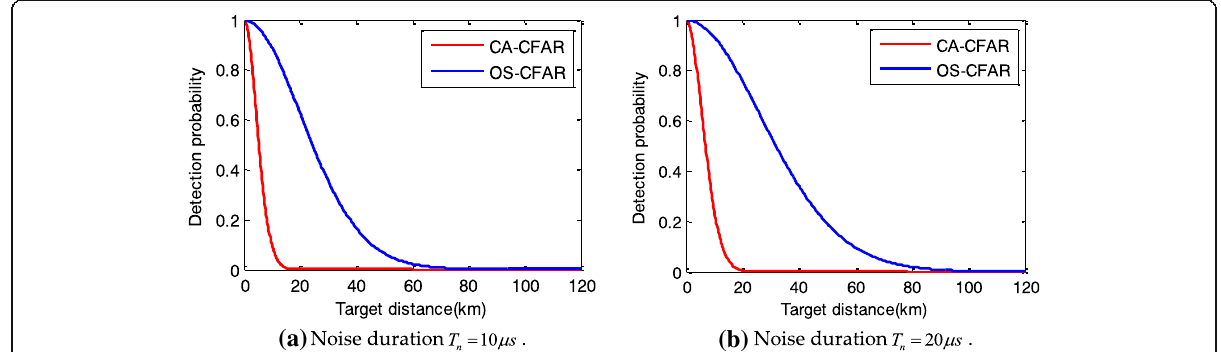
Fig. 9 Effect of smart noise convolution power-cooperative jamming on two detectors ’ performances. a Noise duration T n = 10 μ s. b Noise